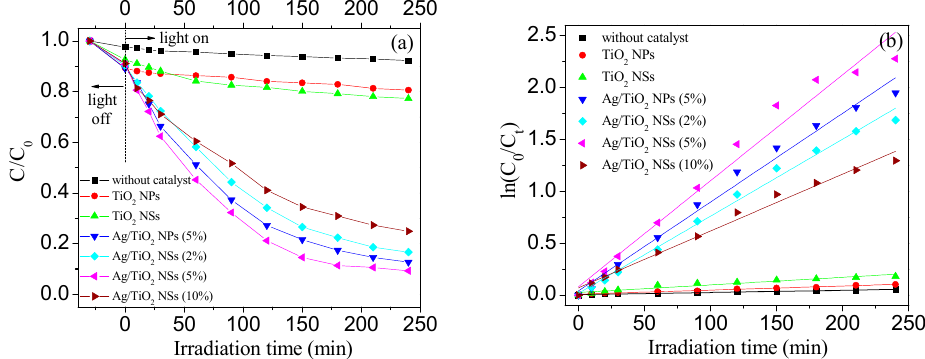
Figure 9. ( a ) Time-dependent degradation efficiency of gaseous HCHO by different catalysts under visible light; ( b ) the related degradation kinetics. Conditions: RH=45%, C 0 (HCHO) = 0.5